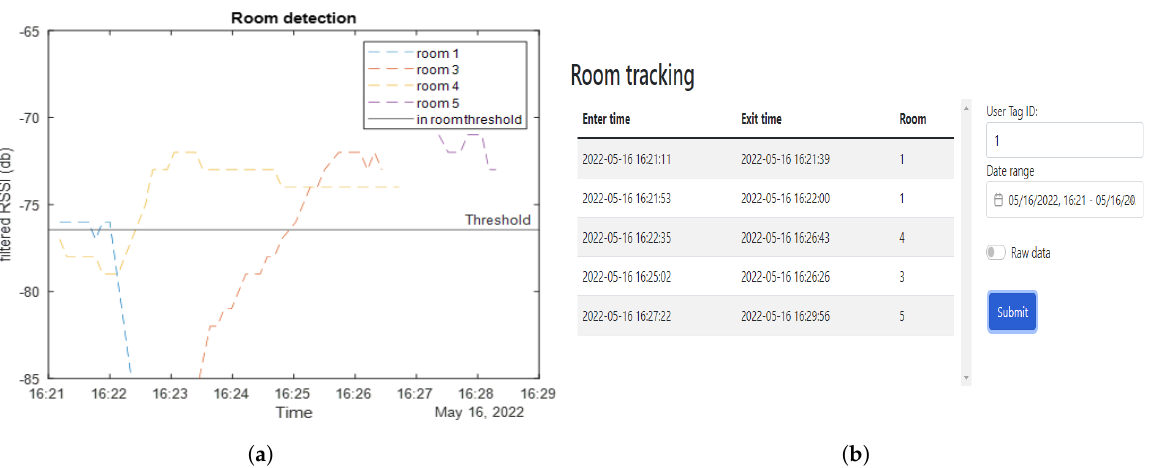
Figure 18. The figures show ( a ) RSSI from beacons in different rooms while moving between rooms, ( b ) web app showing where tag 1 has been within a set time frame.